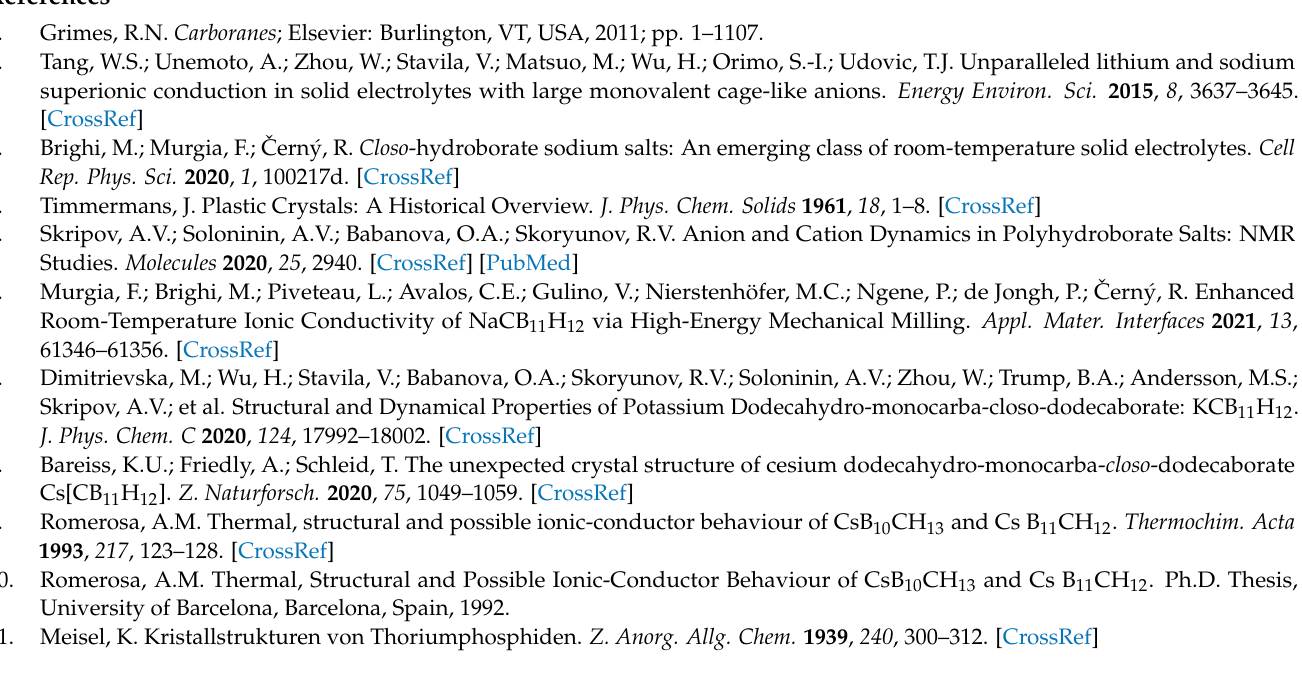
Arrhenius plot of jump correlation frequency; Figure S12: Elastic incoherent structure factors as